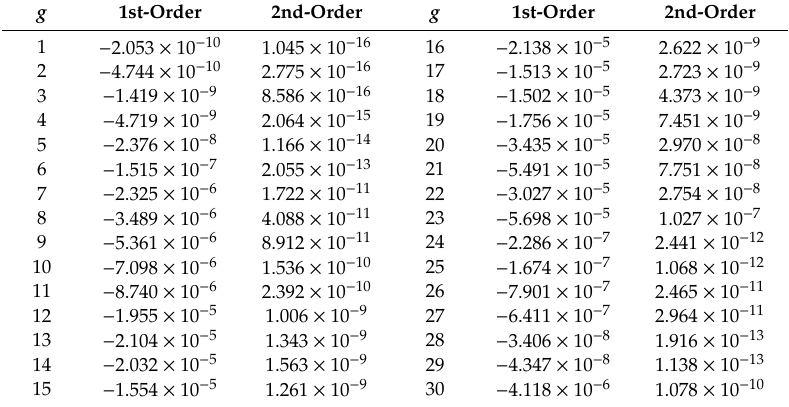
(cid:16) (cid:17)(cid:16) (cid:17) ∂ L / ∂σ g σ g / L , g = 1, ... ,30 and c , i = 3 c , i = 3 (cid:17) (cid:17)(cid:16) (cid:16) σ g σ g ∂σ g ∂ 2 L / ∂σ g / L , g = 1, ... ,30, to the capture cross c , i = 3 c , i = 3 c , k = 3 c , k = 3